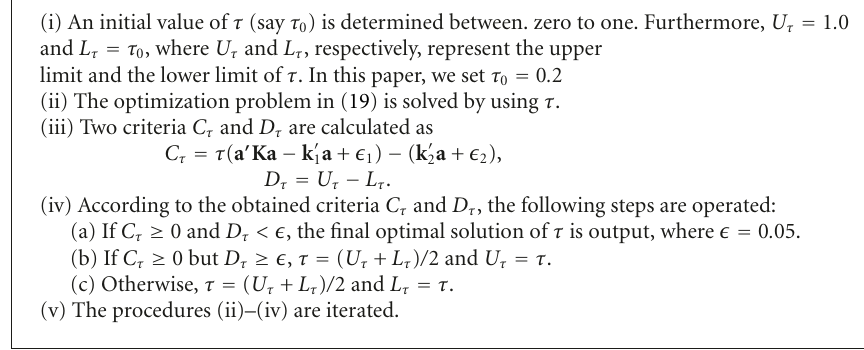
Algorithm 2: Specific procedures to search the optimal τ in the proposed